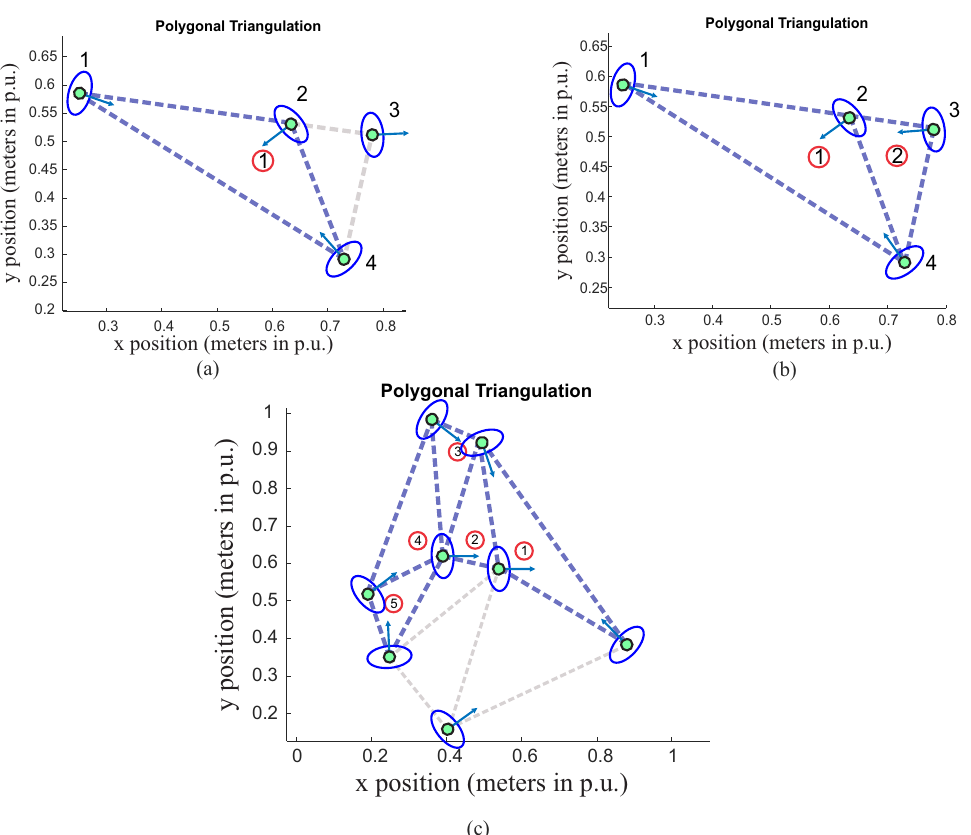
x position (meters in p.u.) Figure 12. Social group classification: ( a ) number of people n p = 4 with person exclusion, ( b ) number of people n p = 4 with person inclusion, ( c ) number of people n p = 8. Red circles are related to calculated center mass of each triangle, while number 1 in the red circles refers to reference triangles ( T ∗ ) and numbers 2, 3, ..., 5 are referred to peripherals T (cid:48)